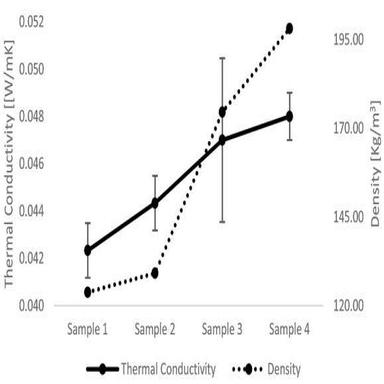
Relationship between density and thermal conductivity.